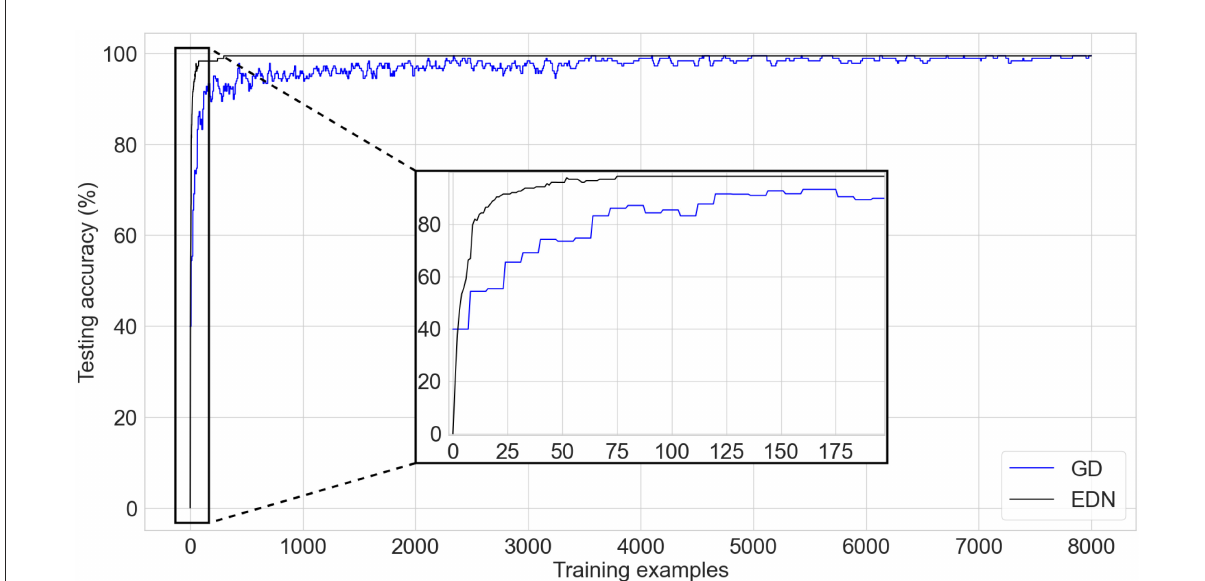
FIGURE5 A comparison of testing accuracy during training on the wine cultivar classification task of EDN (black) and an ANN trained via gradient descent using ADAM optimization (blue). An inset is shown for the first few iterations of training to display the initial emptiness of the EDN network producing no output and the initialization bias of the ANN network already achieving testing accuracy equivalent to random choice. The fast acquisition of information in EDN allows it to overtake the testing accuracy of GD before the first batch update is done at the 8th training instance.